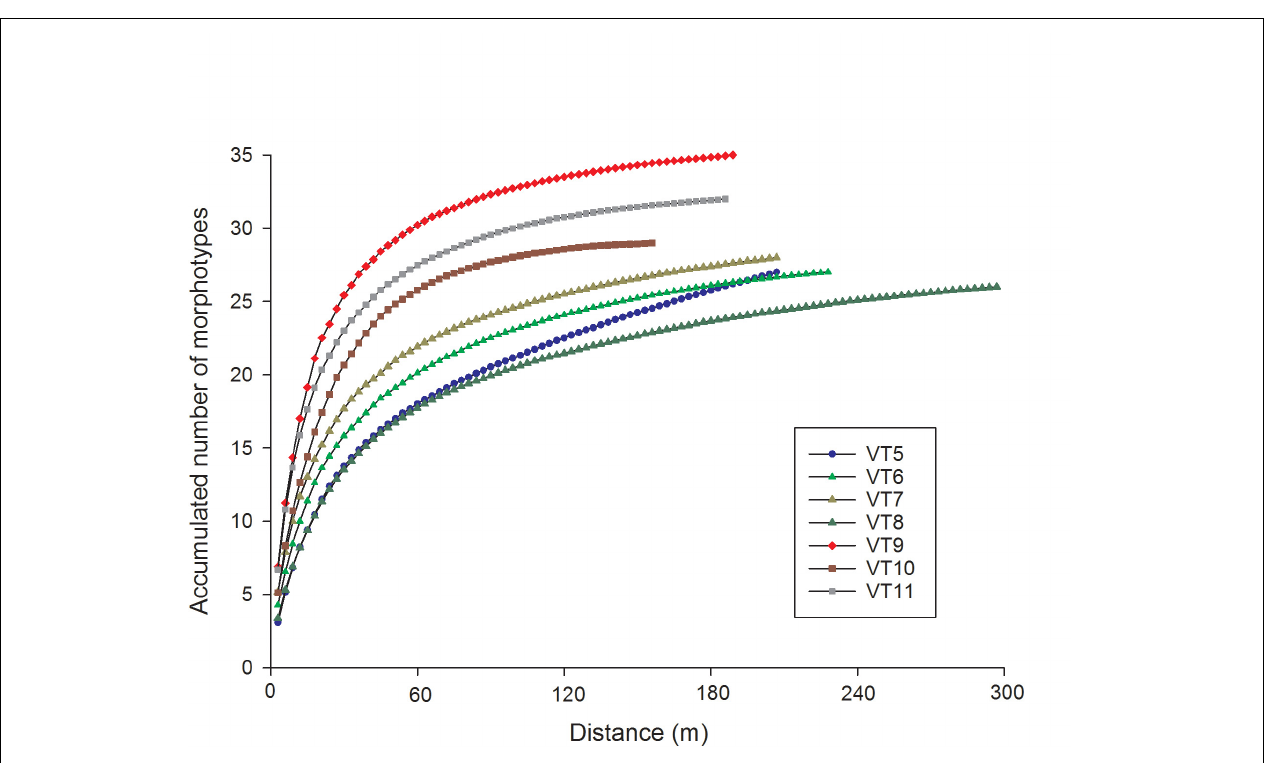
FIGURE 4 | Species accumulation curves for the six ROV transects in Site 1 (VT6, 7, and 8), Site 2 (VT9 and 10), Site 3 (VT5), and Site 4